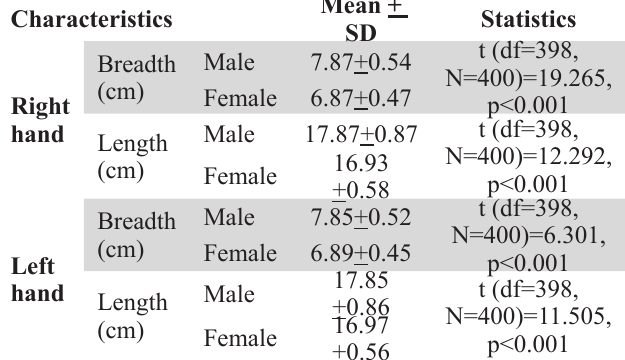
Table 1. Comparison of hand dimensions for male and female